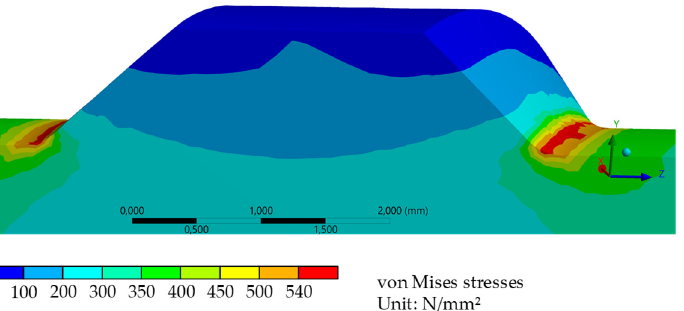
Figure 9. Notch stresses in the center of a transversal rib of the specimen with a nominal diameter of 12 mm and the smallest fillet radii of the FEM analysis .